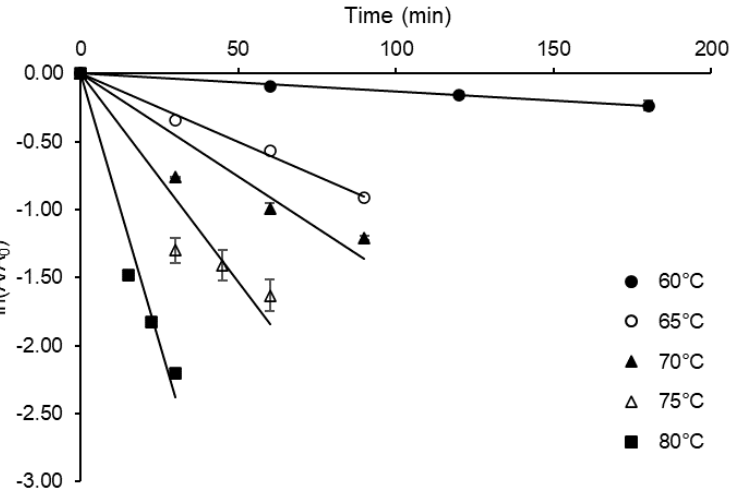
Figure 4. Semi-log plots of the residual activity coefficient ( I / I 0 ) of Aspergillus terreus URM4658 inulinase versus time.